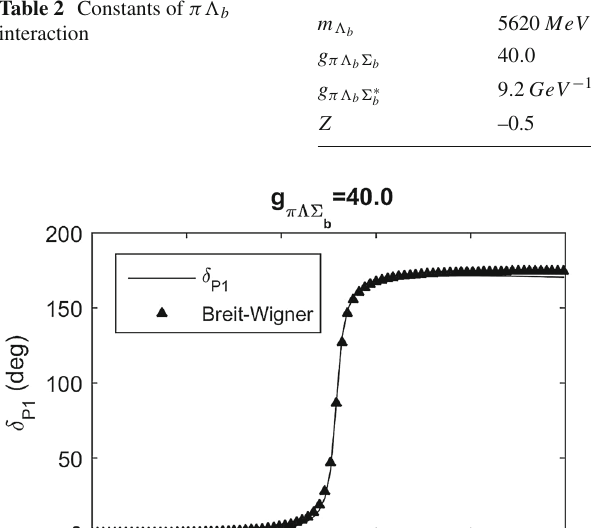
Table 2 Constants of π(cid:2) b